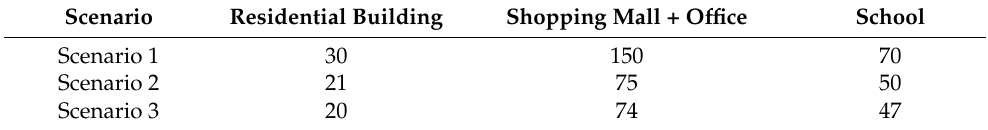
Table 7. Annual power consumption per building area for Scenarios 1–3 (unit: kWh/m 2